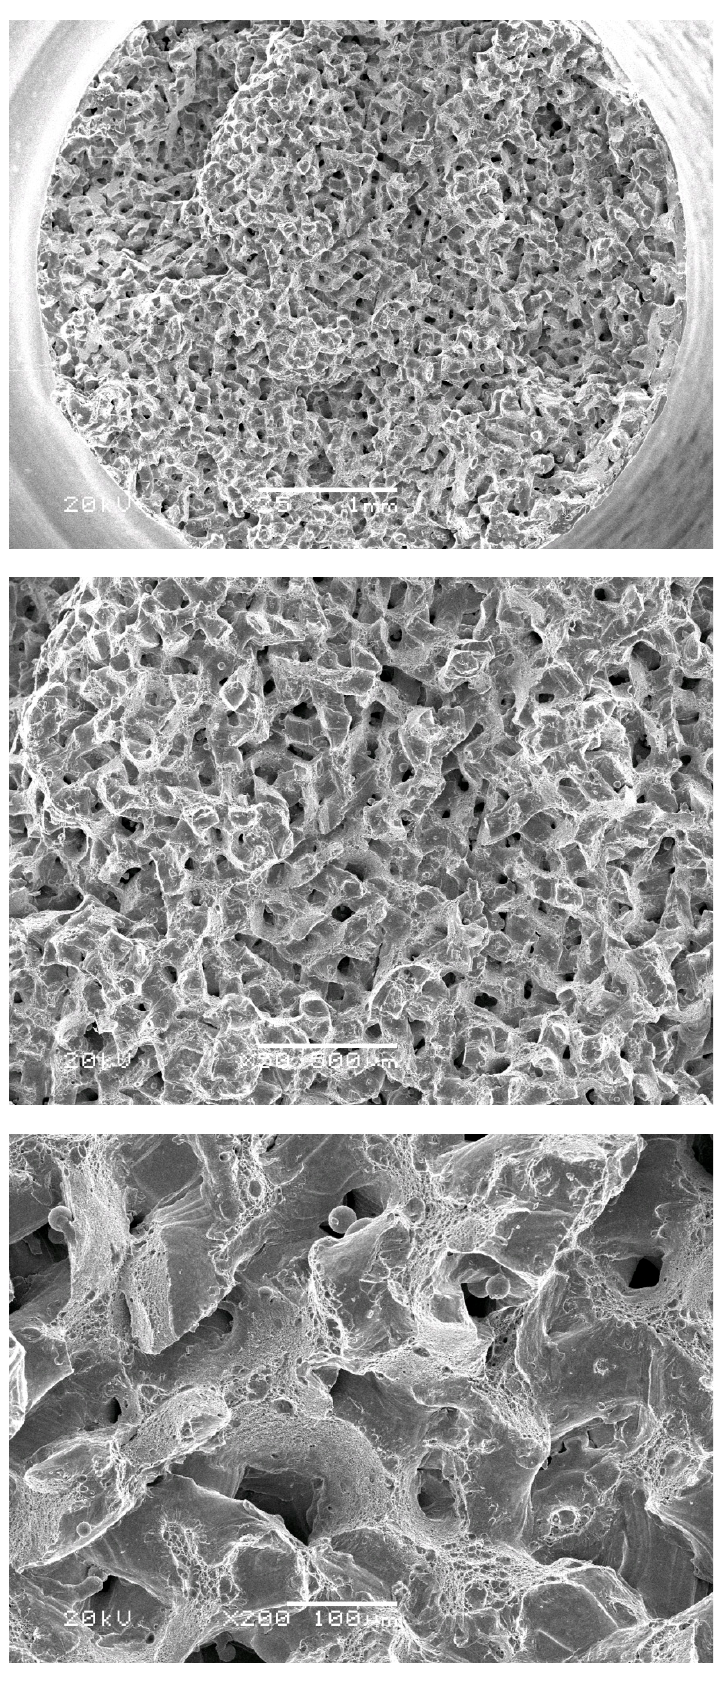
Figure 7. SEM micrographs (25×, 50× and 200×) of specimen 7.